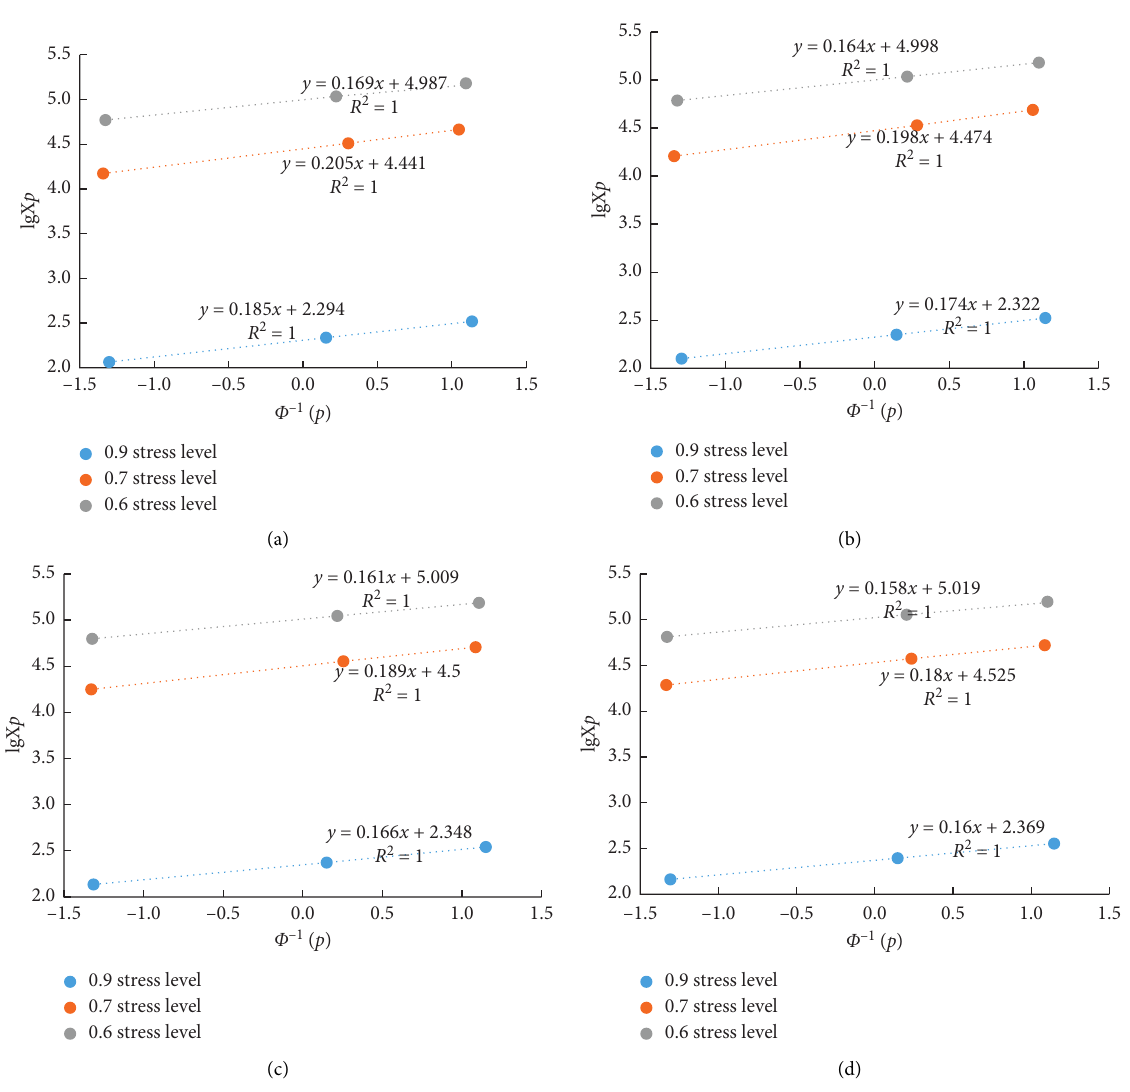
Figure 5: RC linear regression. (a) RC (0d). (b) RC (30d). (c) RC (60d). (d) RC